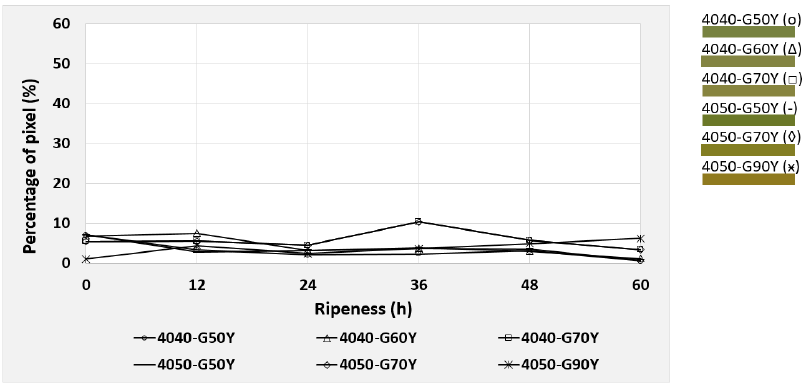
Figure 14. Development of the four most dominating pulp colors of cv. “ Kent ” mangos during the 70 post-ripening process, depicted as NCS color codes. h post-ripening process, depicted as NCS color codes.